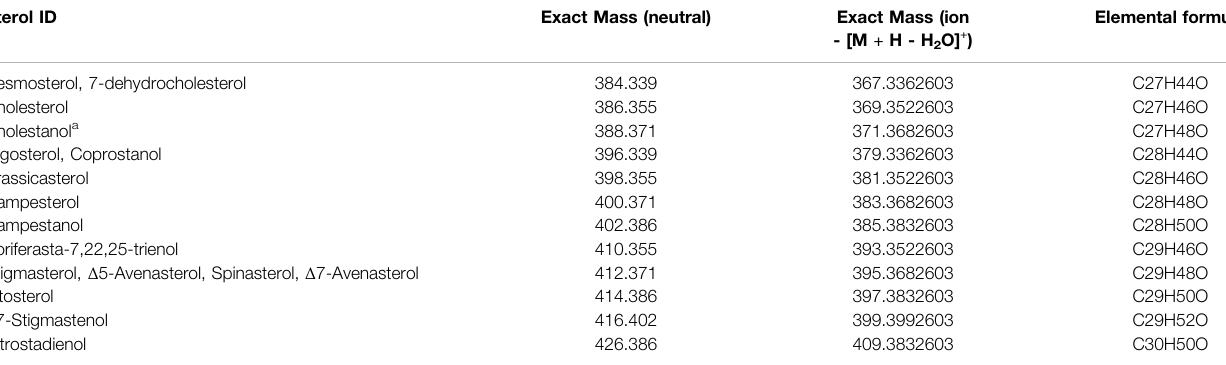
TABLE 1 | Summary of identi fi ed and con fi rmed sterols in S. acutus unsaponi fi able lipids, selected based on agreement with previously published literature Toivo et al. (2001), Fernandes (2007), Ryckebosch et al. (2014), Ahmed et al. (2015). Sterol